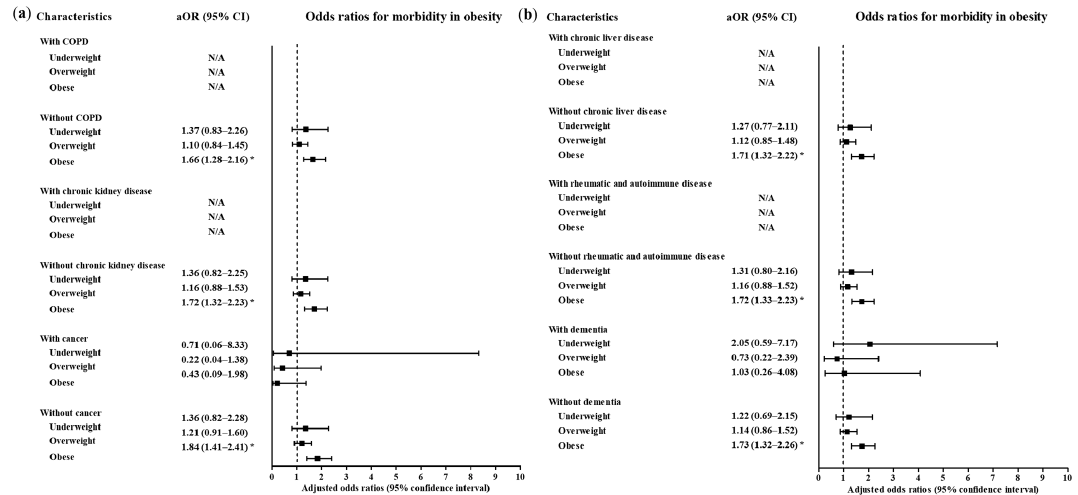
Figure 4. Subgroup analyses to obtain the adjusted odds ratios (95% confidence interval) for the maximum level of morbidity during hospitalization according to age, sex and hypertension ( a ) and heart failure, chronic heart disease and asthma ( b ). (* p < 0.05).